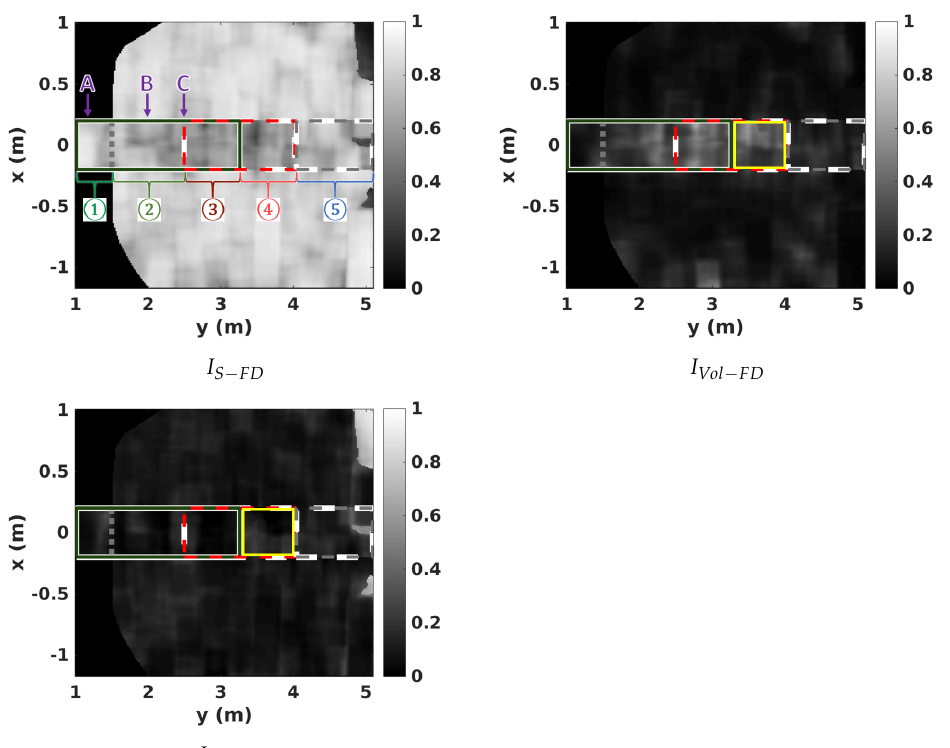
Figure 10. 2D normalized intensity components of the Freeman–Durden [30]